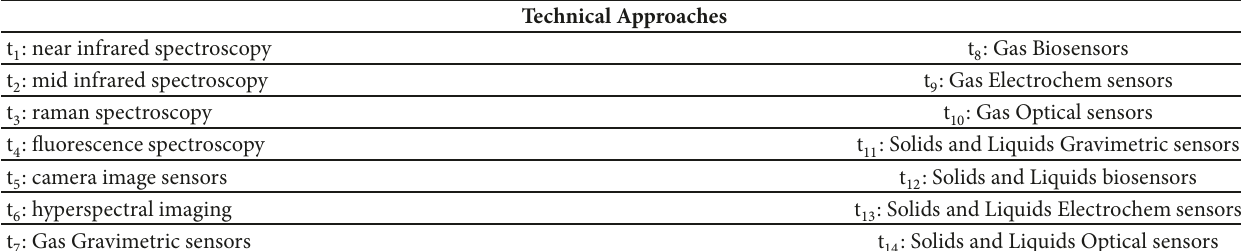
Table 1: The set T of technical approaches.